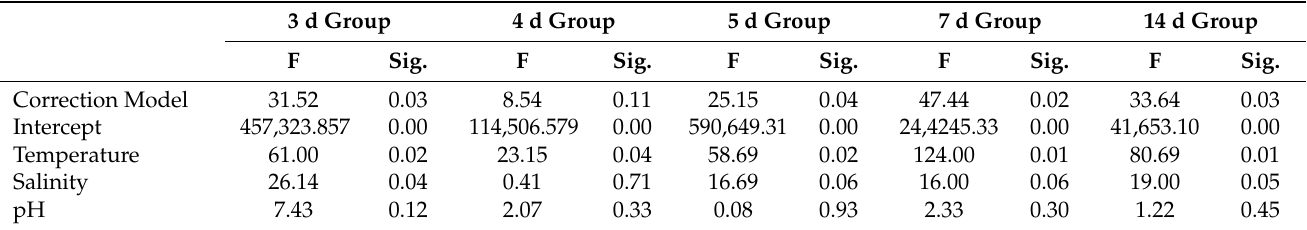
Table 7. ANOVA results for the orthogonal experiment (3–14